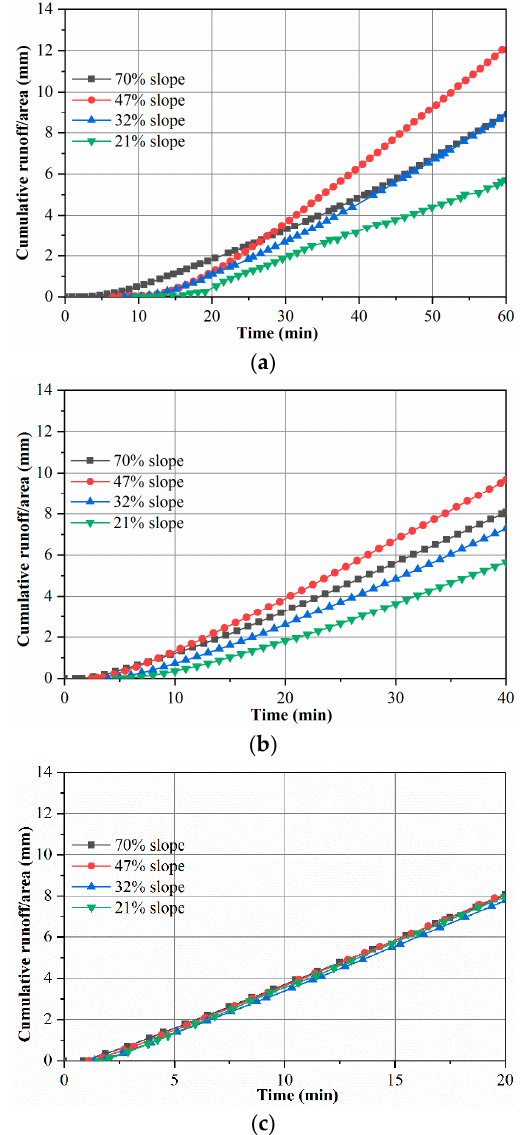
Figure 6. The cumulative runoff per unit area as a function of time of each slope under different rainfall events: ( a ) Dry run; ( b ) Moderate run; ( c ) Wet run. events: ( a ) Dry run; ( b ) Moderate run; ( c ) Wet